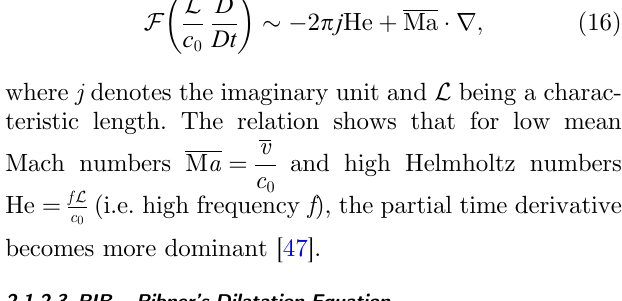
Figure 2. (a) Front and side views of the ori fi ce obstructing the upper half of the cross section, (b) full CFD domain and (c) CA domain with indicated sensor positions K 1 – K